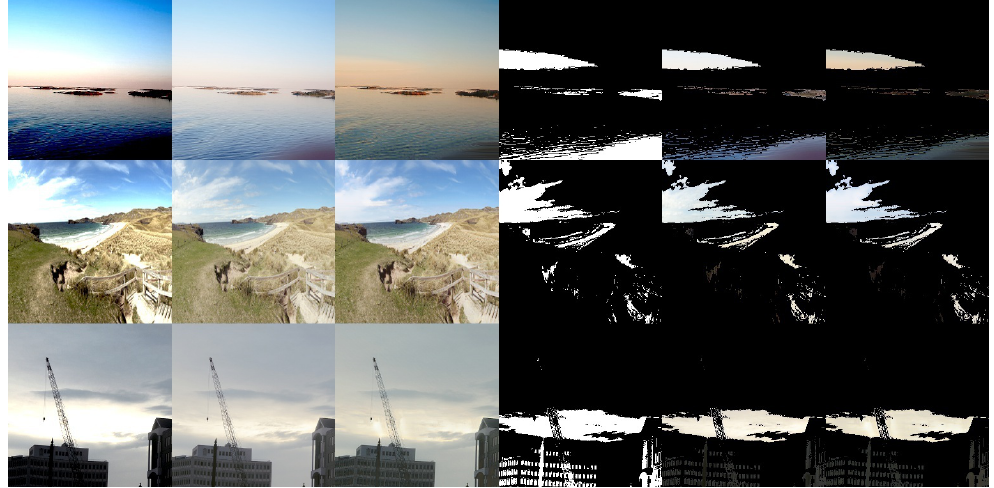
Figure 4. Samples for the DHH method (training). Columns 1–3 are the input LDR image and corresponding tone mapped HDR target and prediction, respectively. Column 4 is a mask showing the fully saturated ( [ 255,255, 255 ] ) and fully under-exposed ( [ 0,0, 0 ] ) pixels of the input. Columns 5 and 6 show the masked target and masked prediction, respectively.